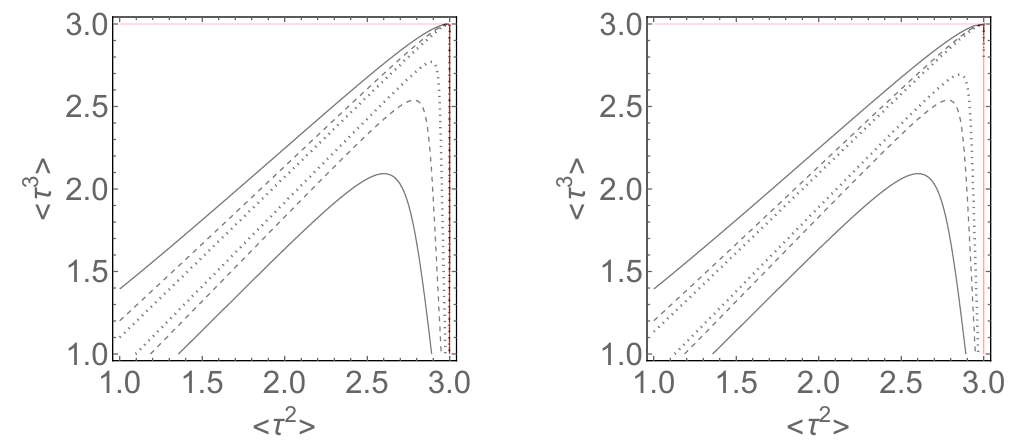
Figure 6 . We plot the smallest ratio r 2 of eigenvalues of the physical Yukawa couplings Y the maximum one with respect to h τ 2 i and h τ 3 i by setting | χ | = 0 . 1 and | χ | = 0 . 01 in the left and right panels, respectively and other moduli values are set as in eq. (3.35). In both panels, red lines correspond to r 2 = 0 , namely rank-two Yukawa matrix. In the left (right) panel, the dotted, dashed and solid curves correspond to the values for 4 × 10 − 5 (3 × 10 − 7 ) , 2 × 10 − 5 (2 × 10 − 7 ) , and 10 − 5 (10 − 7 ) ,